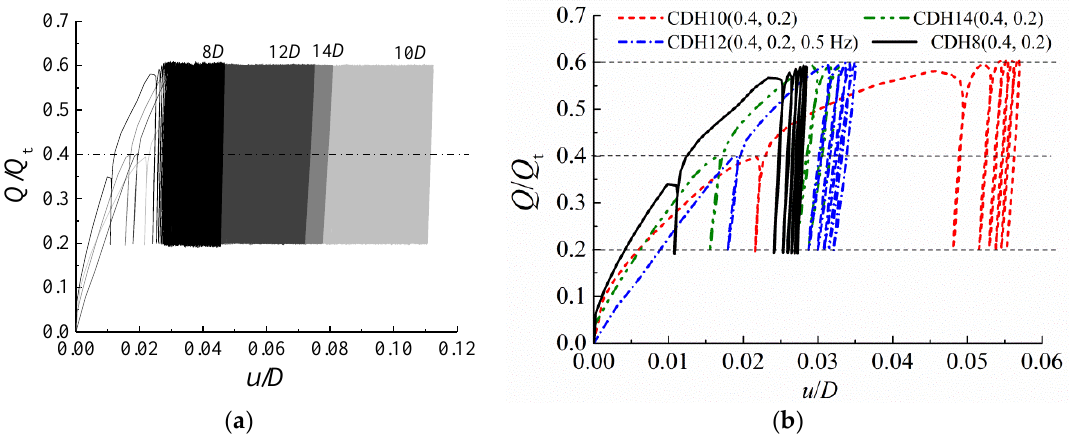
Figure 5. Standardized load – displacement curves at different embedment ratios ( a ) N = 1200; ( b ) N = 6.